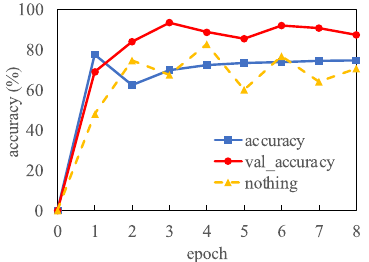
Figure 7. The learning results. The vertical axis provides the accuracy rate, and the horizontal axis is the number of epochs. The red line indicates validation accuracy (val_accuracy), and the blue line indicates training accuracy (accuracy).